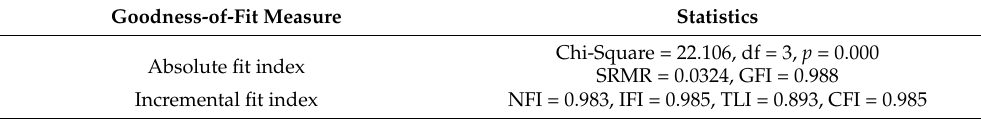
Table 4. Goodness-of-fit of the path model.